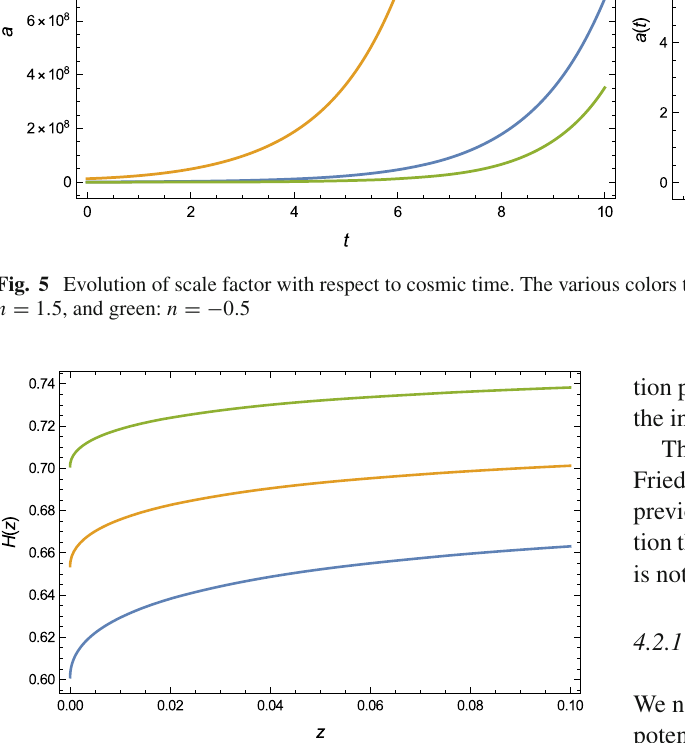
Fig. 6 Evolution of Hubble parameter with respect to redshift. The variouscolorstakeonthefollowingvaluesoftheindex n .Blue: n = 2 . 5, yellow: n = 3 . 5, green: n = 4 . 5